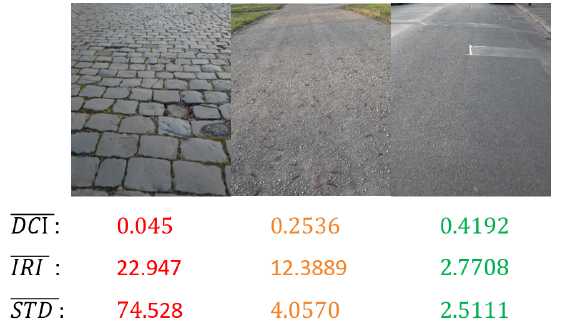
Based on Figure 6, in which red numbers represent the worst comfort in the respective calculation method and green numbers the best comfort, it can be seen that the three calculation meth- ods behave similarly for three edges with different road qualit- ies. The cobblestone road is rated the worst in every method, the gravel road with medium values and the asphalt road is rated the best.